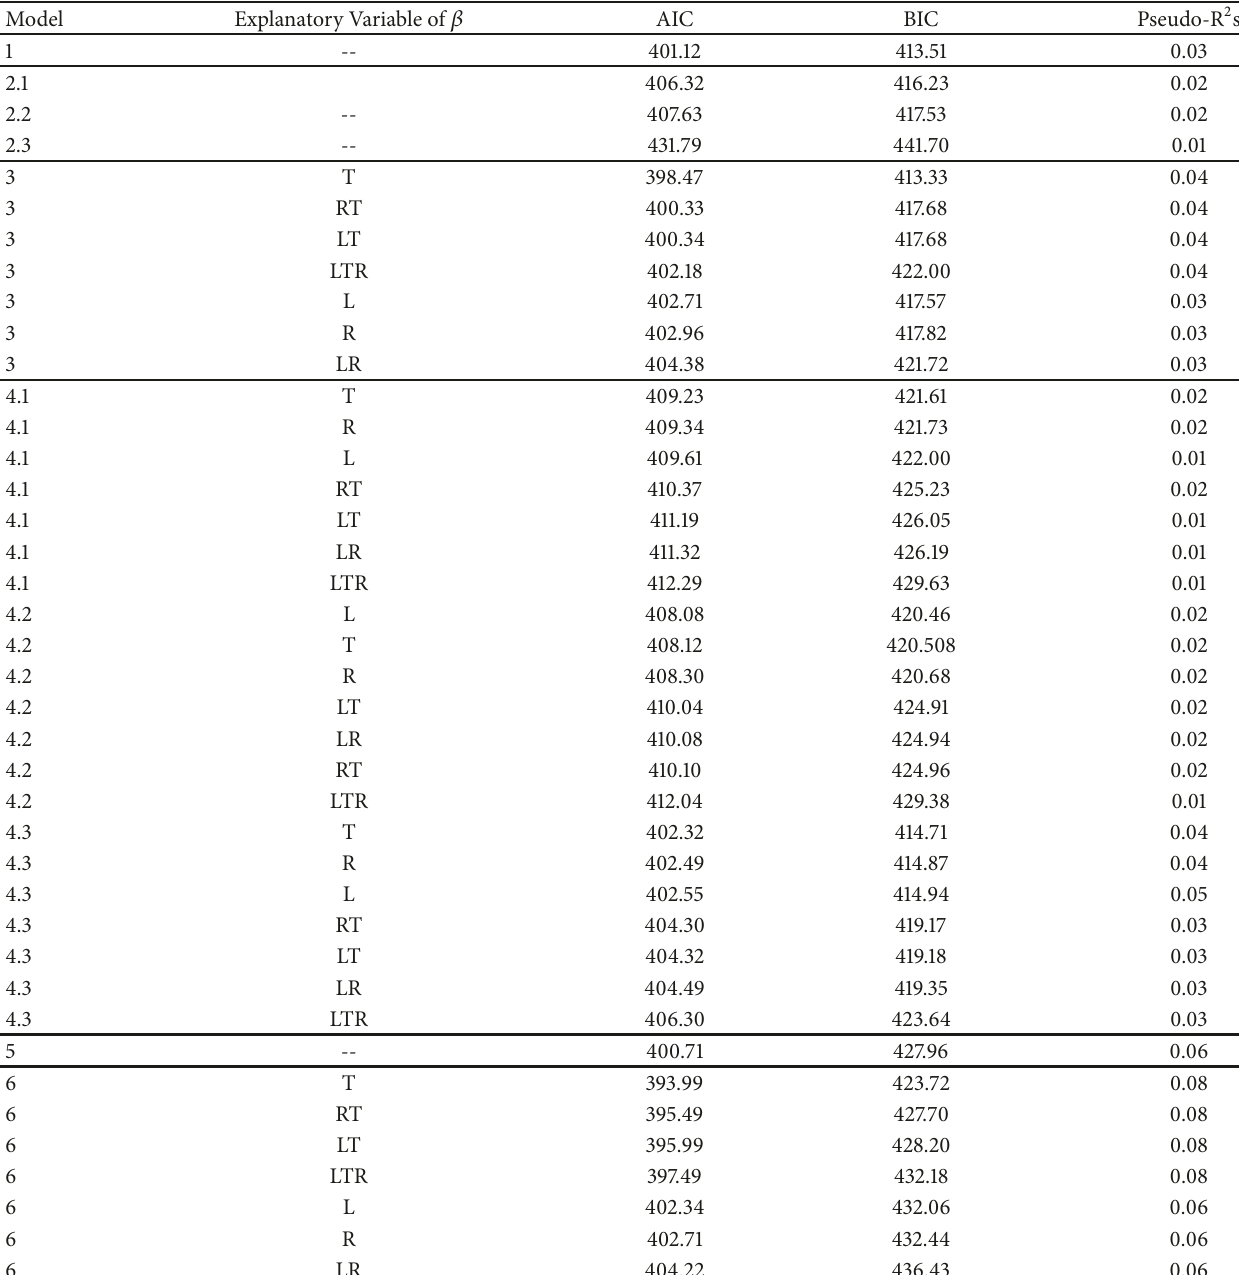
Table 4: AIC, BIC, and Pseudo R2 of 6 main models and their specific